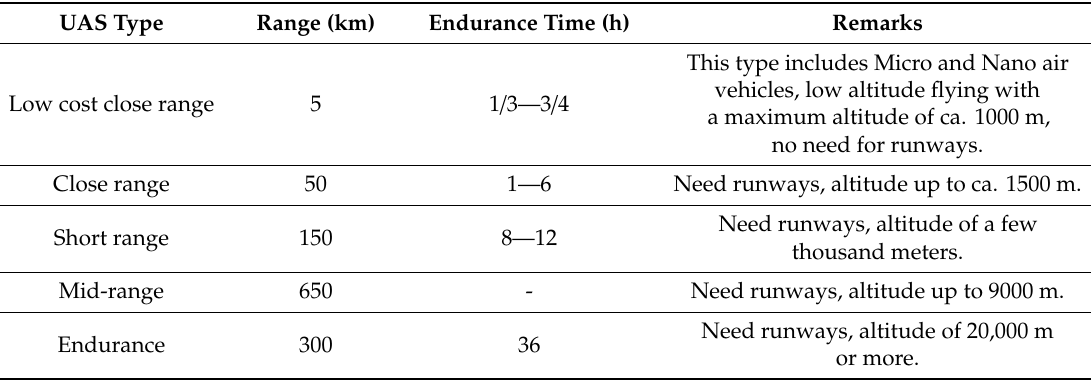
Figure 6. Simplified classification of UAS platforms based on their work range (km) and battery endurance time (h). The different classes include low-cost close-range (CR), close-range (CR), short-range (SR), medium-range (MR) and high-endurance (Endurance) platforms. A full description of these classes is provided in Table 3. Table 3. Description of the simplified classification of